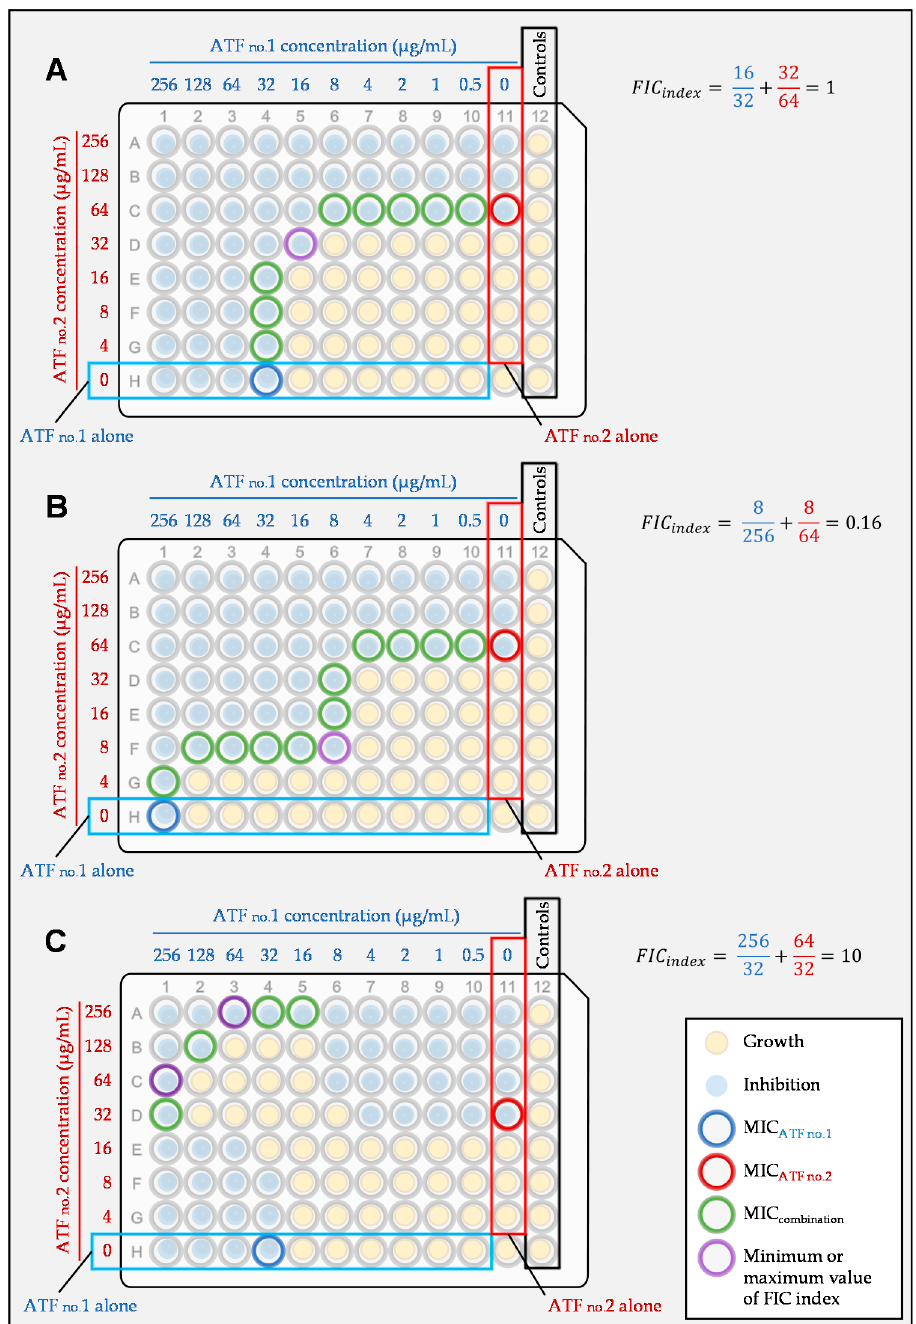
Figure 4. Example of a synergistic ( A ), indifferent ( B ), and antagonistic ( C ) interaction of two antifungals according to the checkerboard method and calculated by the FIC index. If there is no FIC index > 4, then the lowest FIC index is retained. If there is at least one FIC index > 4, then the highest FIC index is retained. Synergy is defined as a FIC index ≤ 0.5, indifference as a FIC index > 0.5 to 4, and antagonism as a FIC index > 4.